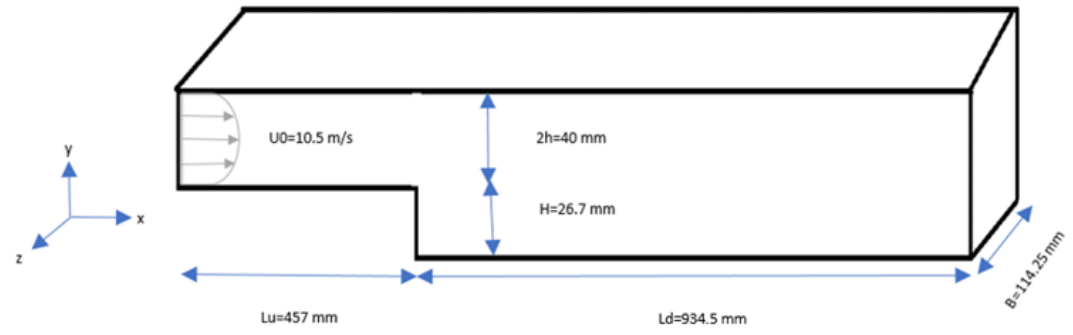
Figure 3. The geometry considered for numerical simulation.